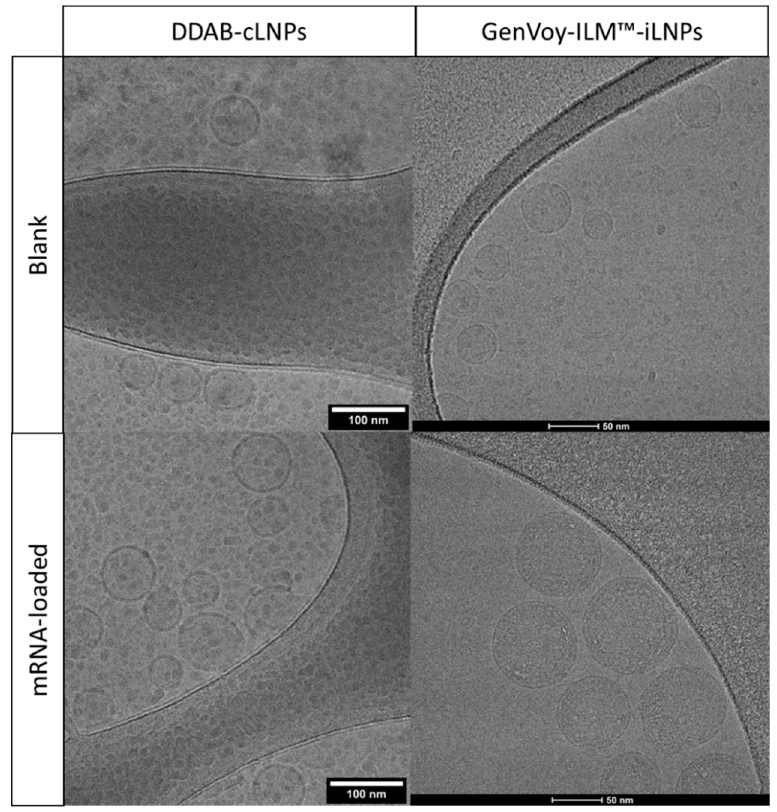
Figure 9. Cryo-TEM images of blank and mRNA-loaded DDAB-cLNPs (40,000× magnification, 200 kV) and GenVoy-ILM™ iLNPs (96,000× magnification, 300 kV).